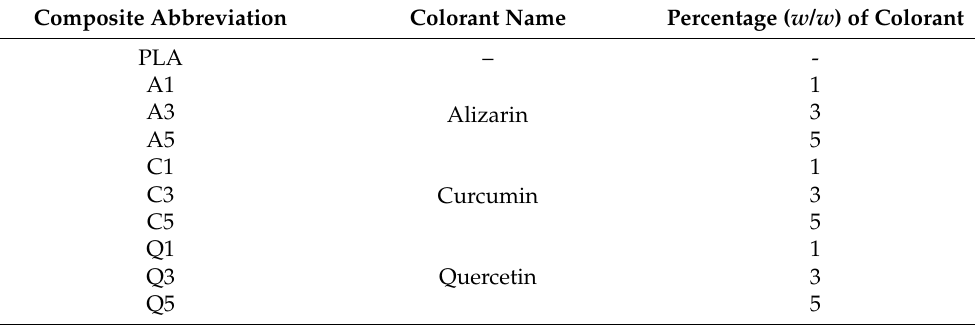
Figure 1. Our 600-nozzle pilot-scale electrospinning machine. Table 2. PLA/dye composites used for the spinning trials.